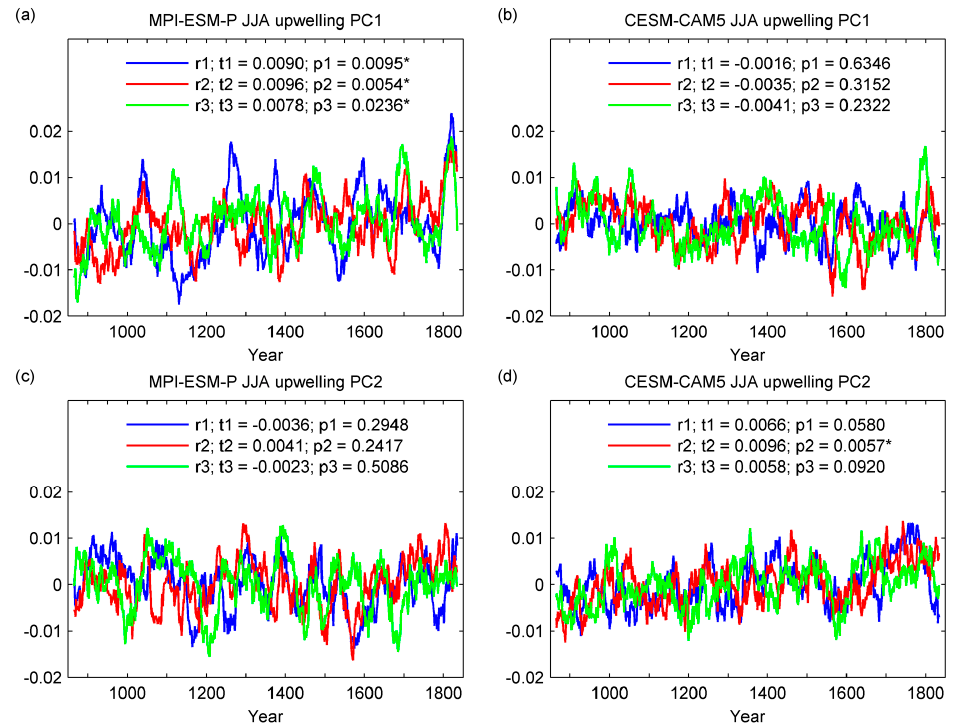
Figure 4. First principal component (PC) time series corresponding to the first EOF mode for all the simulation in ( a ) MPI-ESM-P and ( b ) CESM-CAM5 and second PC time series of ( c ) MPI-ESM-P and ( d ) CESM-CAM5. The plotted PCs are smoothed by a 31-year moving mean window and r1, r2, r3 represent the three simulations. t1, t2, t3 are the trends (per 1000 years) of each simulation with p1, p2 and p3 indicating their p -values, respectively, and the star symbols mark the simulations that pass the significance test at the 95%